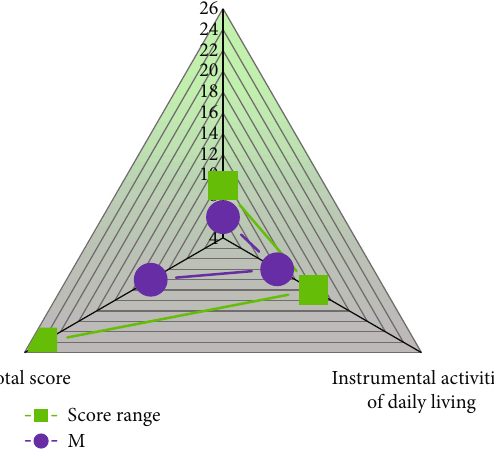
Figure 2: The age distribution of the elderly in the lost-to-follow-up group and the response group. Table 1: General demographic data of the elderly in the community.